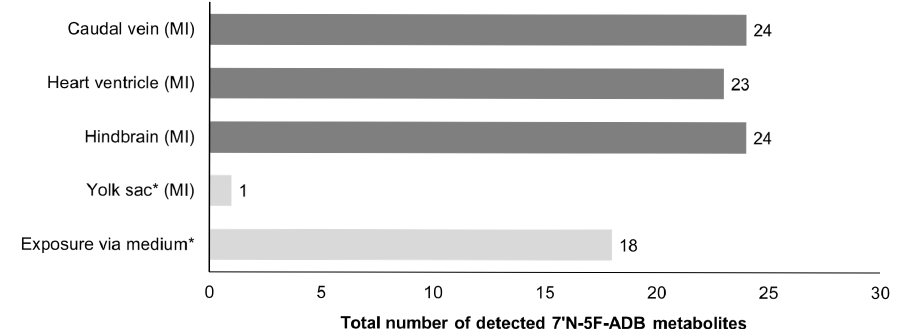
Figure2. Comparisonofthetotalnumberofmetabolitesproduceddependingondifferentadministration routes in ZF larvae. Results for the samples investigated in this study are represented by the mean value of peak numbers of triplicates of 36 pooled larvae. (MI: microinjection, * these results were quoted from